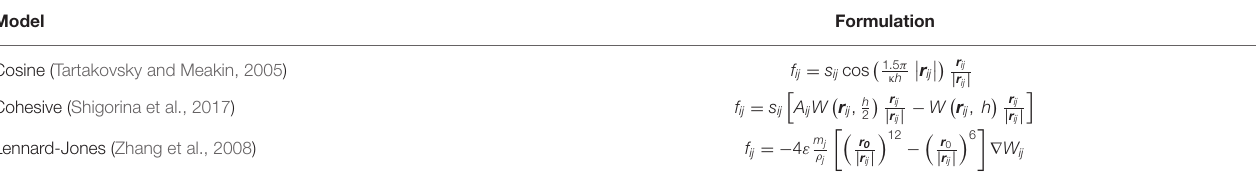
TABLE 3 | Inter-particle force terms for the IPF surface tension model. Model